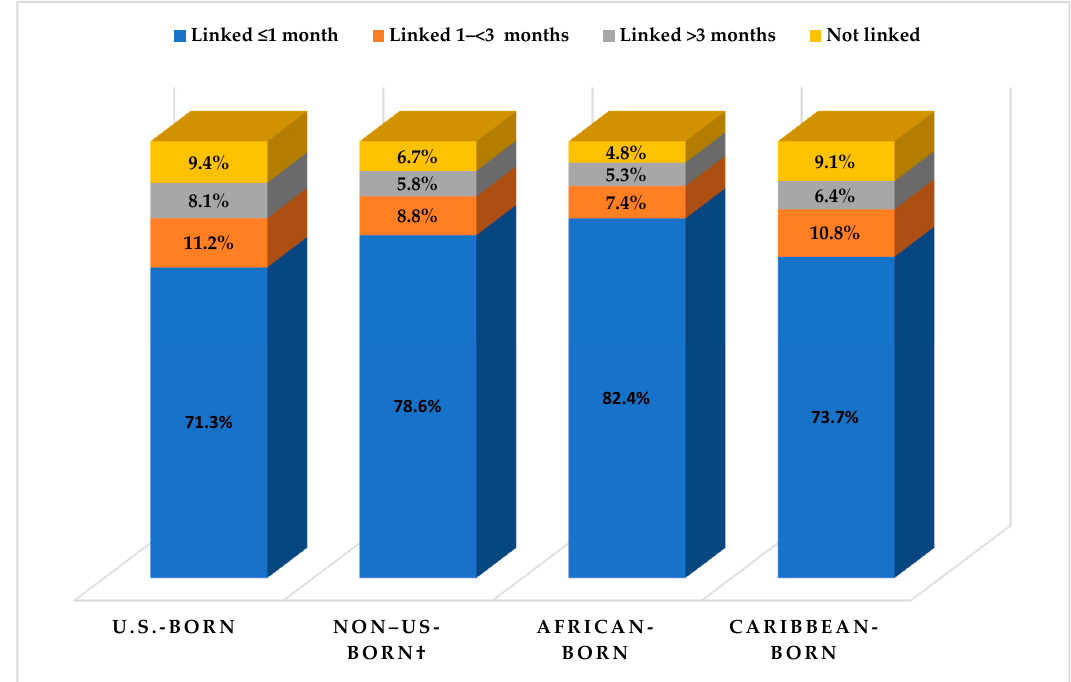
Figure 1. Linkage to HIV infection-related medical care among blacks aged ≥ 13 years with HIV infection diagnosed during 2016, by place of birth, National HIV Surveillance System, 40 U.S. areas. † Includes African- and Caribbean-born blacks.